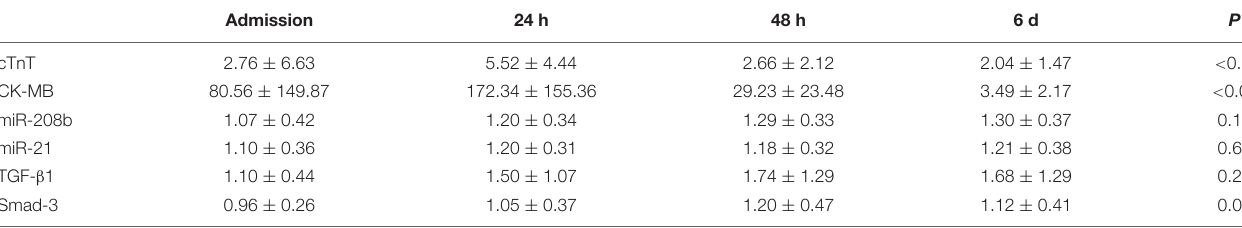
TABLE 2 | Expression of serum indices in AMI patients at different time periods.